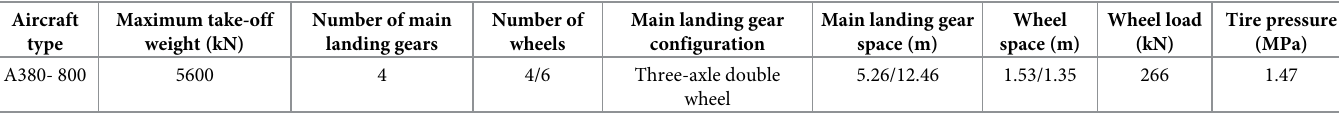
Table 1. Aircraft parameters.